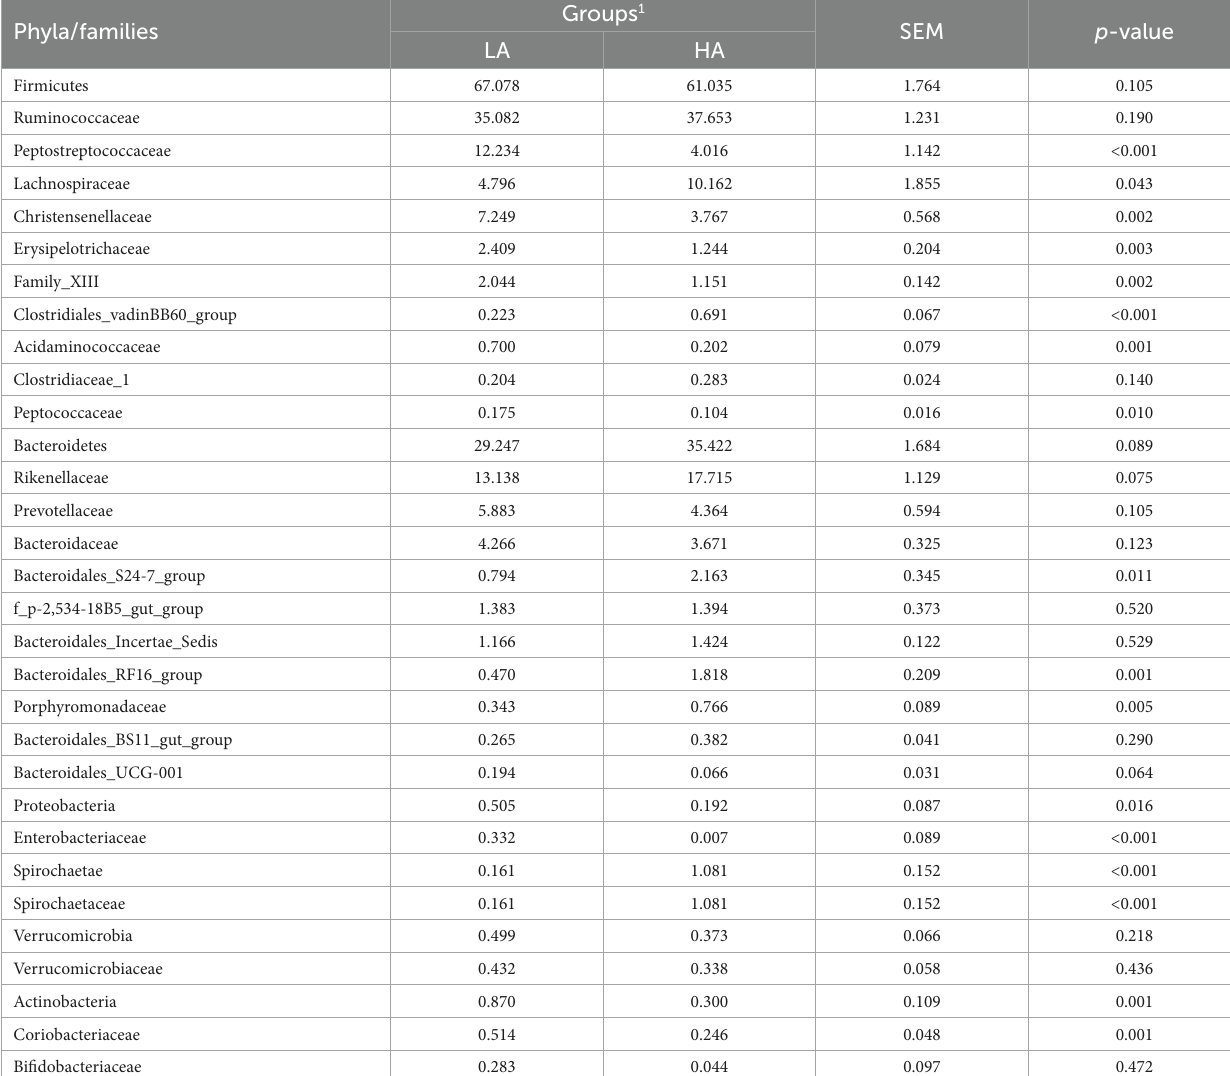
TABLE 2 Phyla and Families of relative abundance >0.1% within the gut microbiota of LA and HA